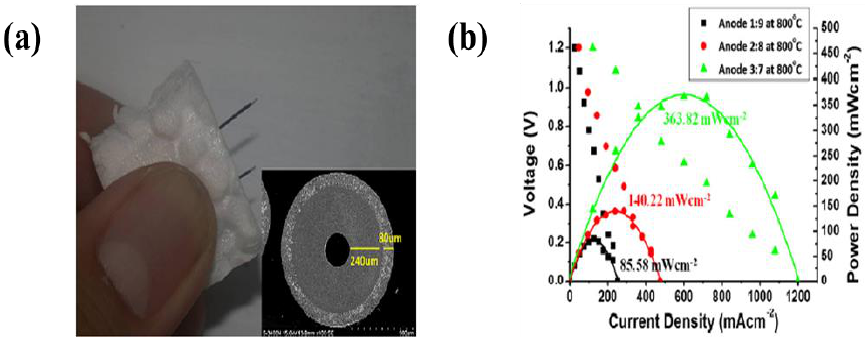
Figure 28. ( a ) Photograph (with an inset for close-up) of typical micro-tubular SOFCs made by consecutive EPD and single-step co-sintering; ( b ) Electrochemical performance of such micro-tubular SOFCs with various anode compositions.